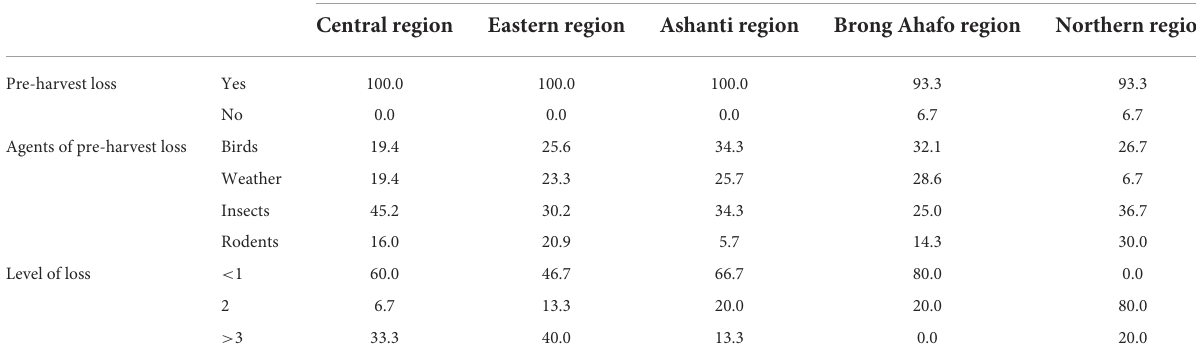
TABLE 4 Pre-harvest loss and associated casual agents experienced by the maize